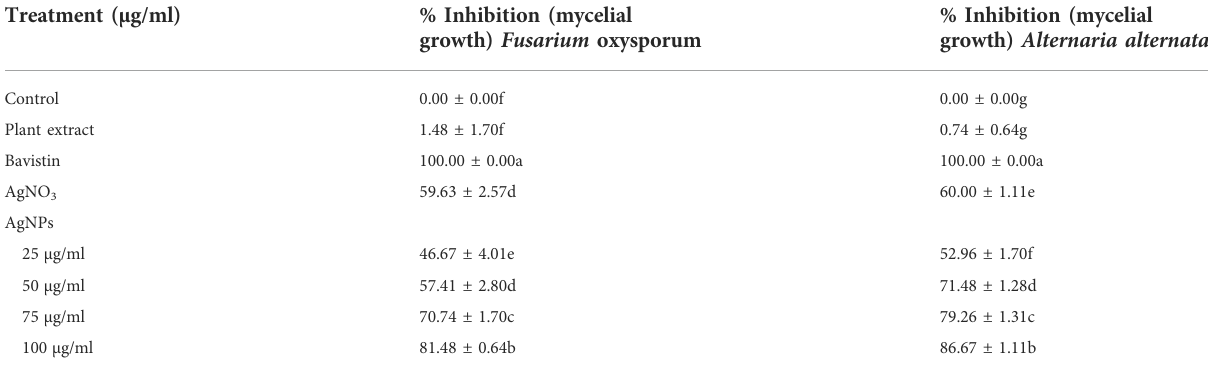
TABLE 3 Mycelial growth inhibition activity of synthesized